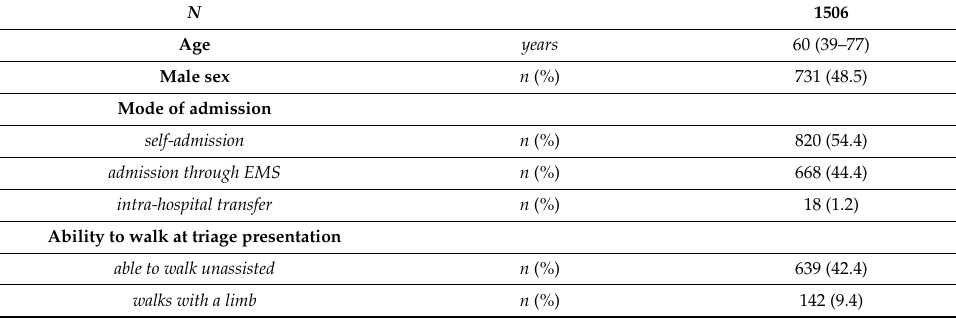
Table 1. Characteristics of study